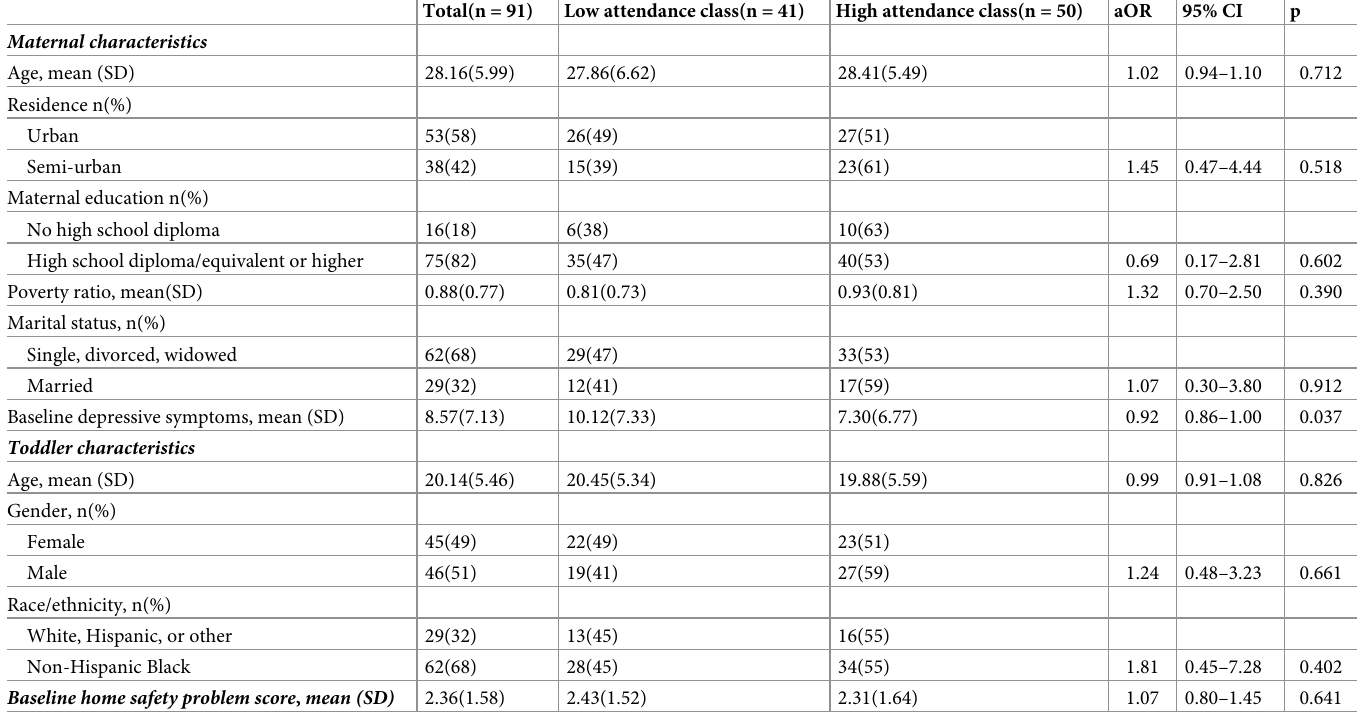
Table 1. Selected sample characteristics in relation to latent class membership (n = 91).